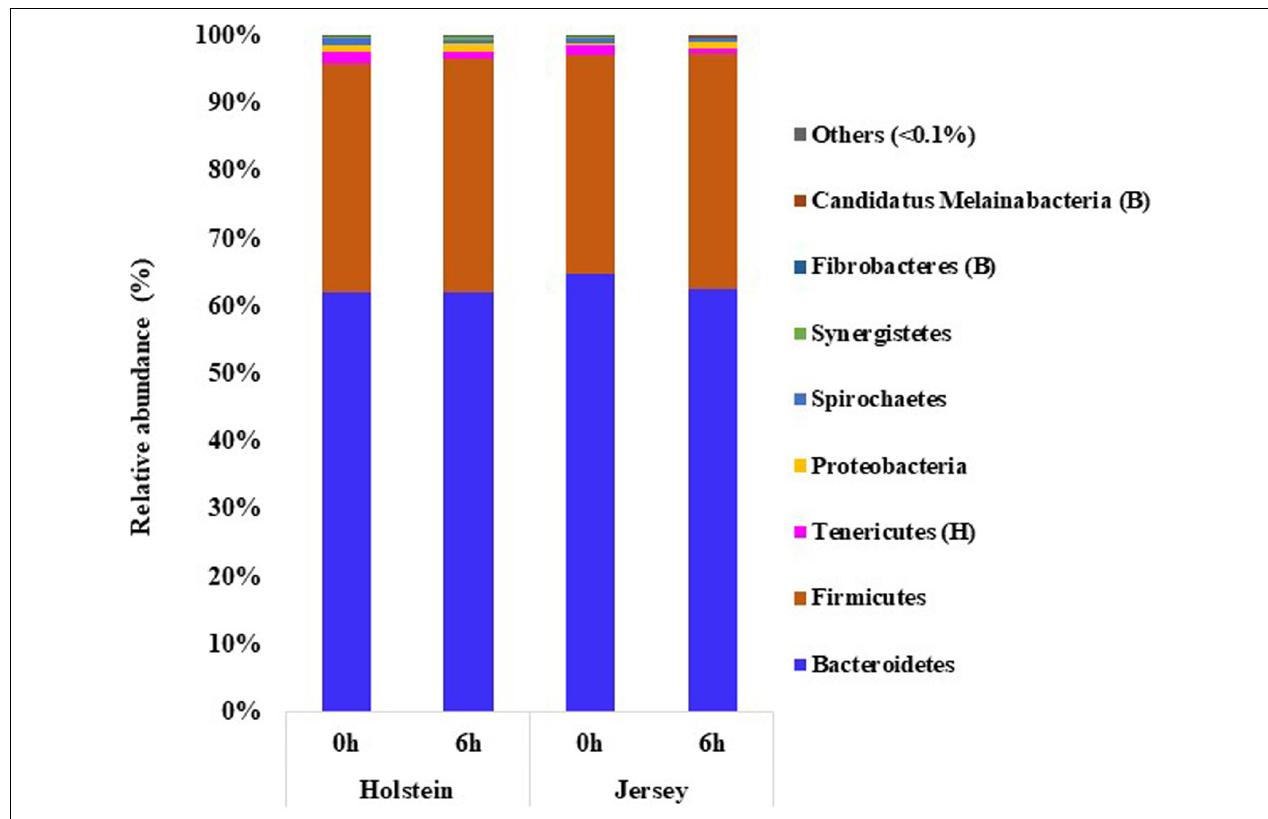
FIGURE 2 | Phyla of bacteria identified in the rumen of the Holstein and the Jersey steers. B, H, and B × H indicate significant ( P < 0.05) difference in relative abundance between breeds, sampling hours, and the interaction between breed and sampling hours,